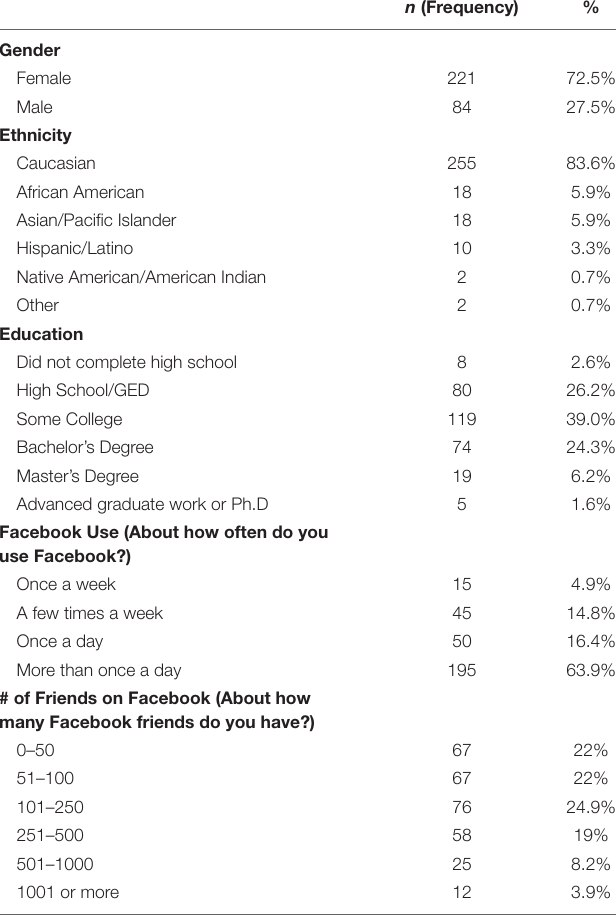
TABLE 1 | Sample characteristics ( N =